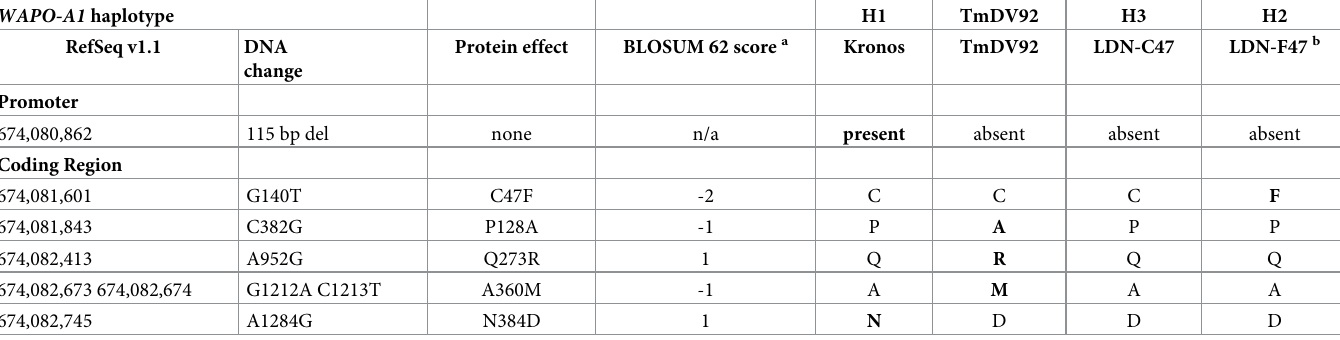
Table 1. Comparison of regulatory and coding WAPO-A1 regions in wild type Kronos (H1 haplotype) and the three genomic constructs used in the transgenic plants. WAPO-A1 haplotype